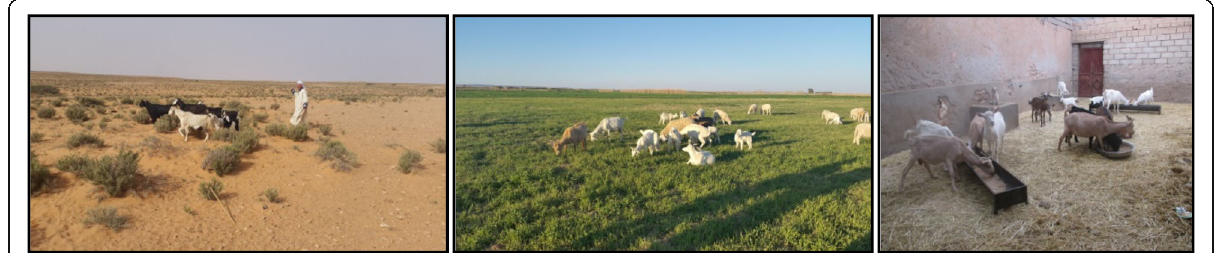
Figure 4 Different production systems. Left: pastoral system. Middle: mixed crop-livestock system. Right: zero-grazing system (personal